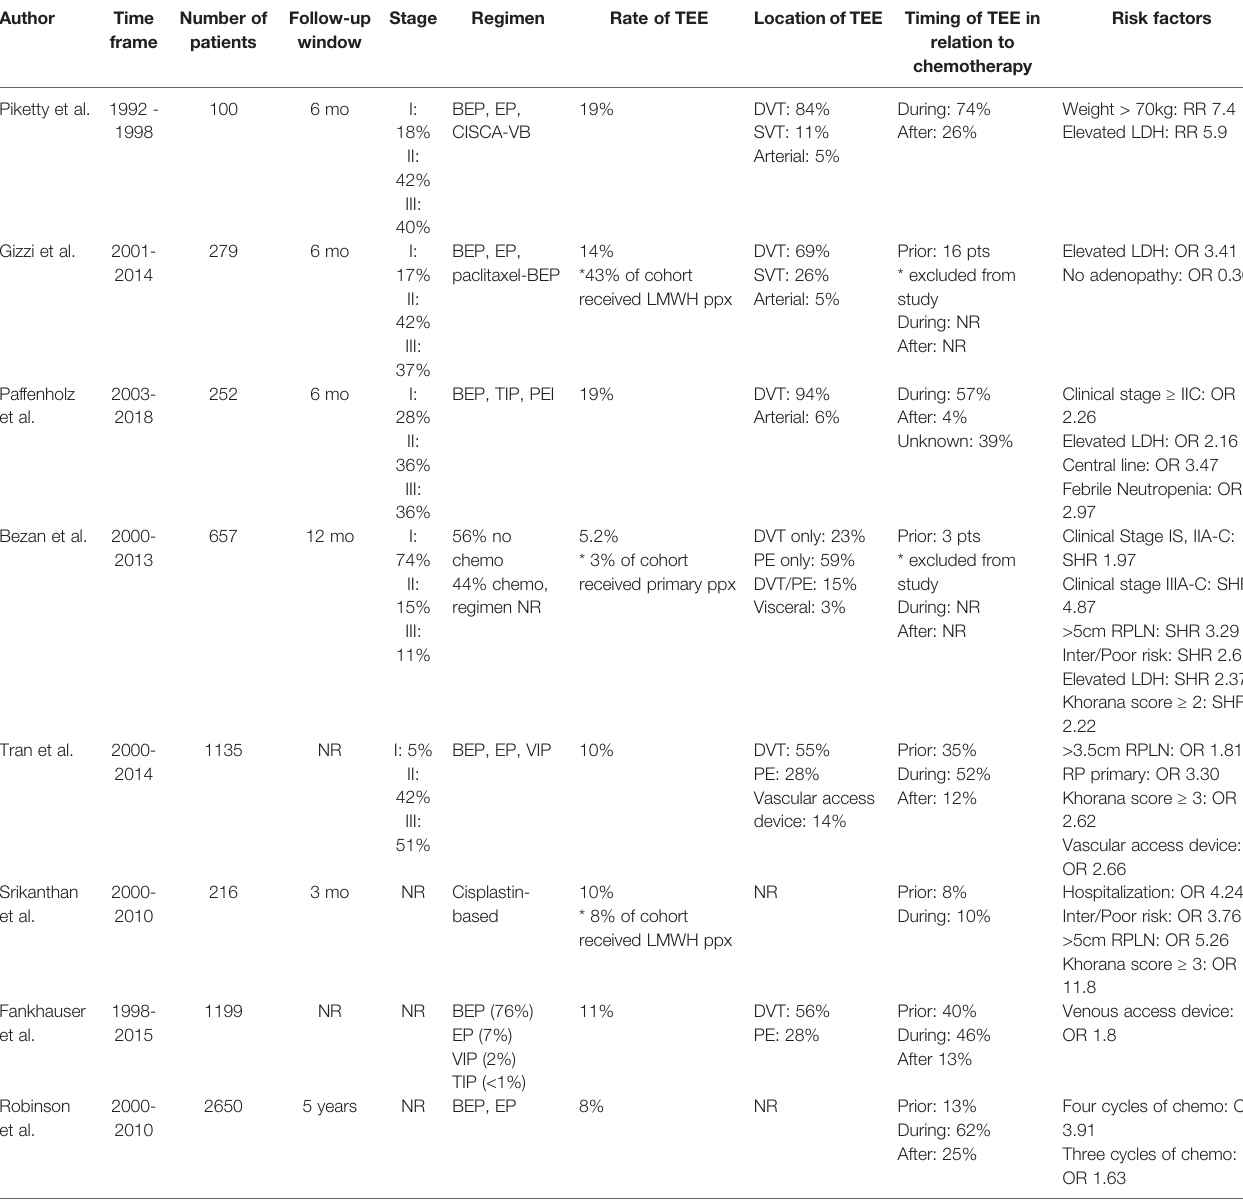
TABLE 1 | Risk factors for thromboembolic events in germ cell tumor